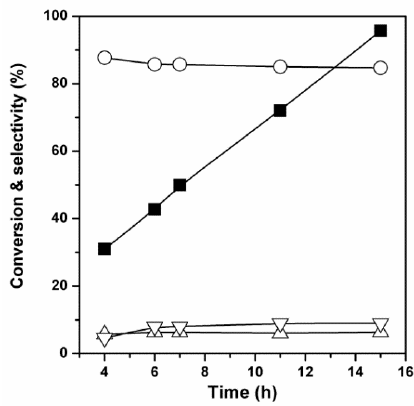
Figure 1. Glycerol conversion and product selectivity as a function of reaction time over 17.5% Ni-2.9% P/Al 2 O 3 -500. Reaction conditions: glycerol 38.0 mmoL, catalyst 0.25 g, 230 °C, 5 MPa H 2 . (  ) conversion of glycerol, selectivity to (  )1,2-Propylene Glycol (1,2-PDO), (  )Ethylene Glycol (EG), and (  ) other byproducts include 1-propanol, ethanol, methanol and acetol.